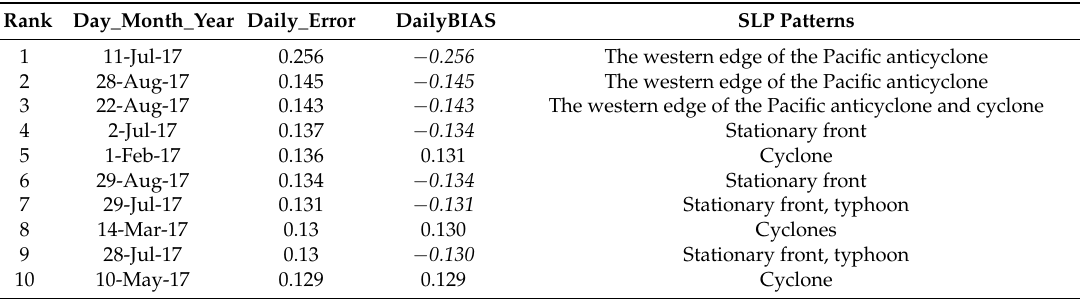
Table 5. Same as Table 2, but for